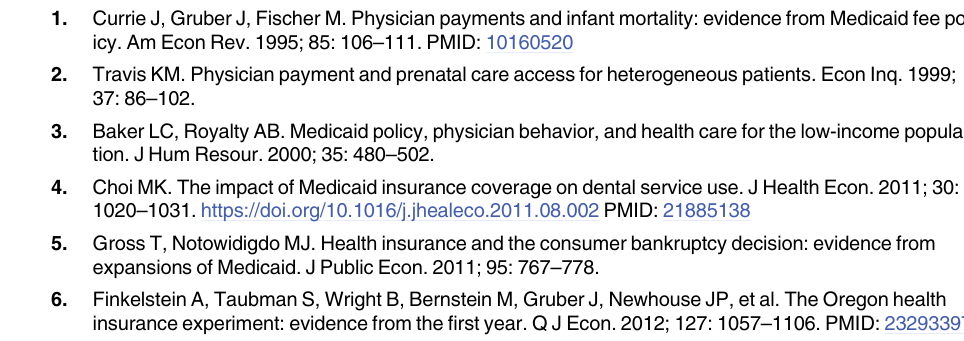
S1 Table. Institutional comparison between the medical assistance and public health insur- ance systems in Japan. S2 Table. Estimation results of the MA assignment